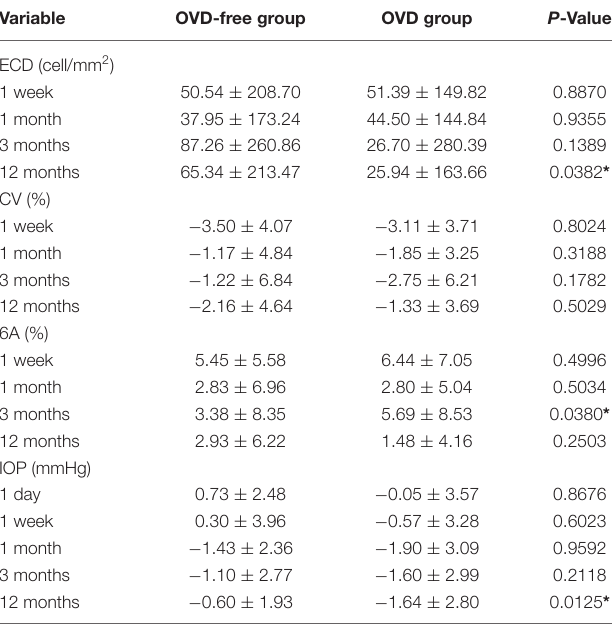
TABLE 2 | Changes in endothelial cells and intraocular pressure in OVD-free/OVD group. Variable